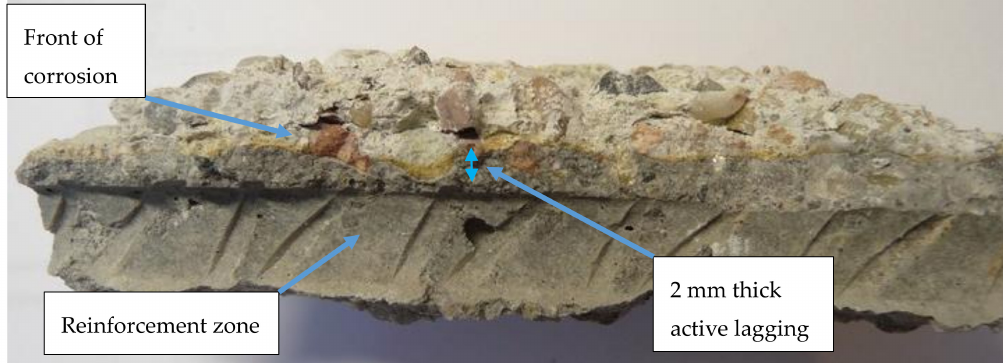
Figure 7. Thickness of non-corroded lagging in borehole No. 1 is only 2 mm.